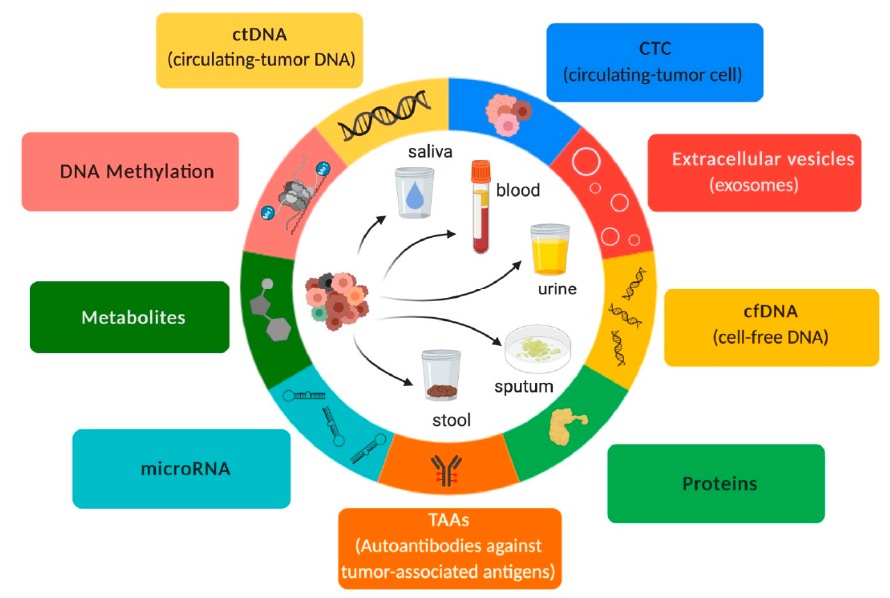
Figure 1. Overview of liquid biopsy. Inspired by Hanahan & Weinberg (192).